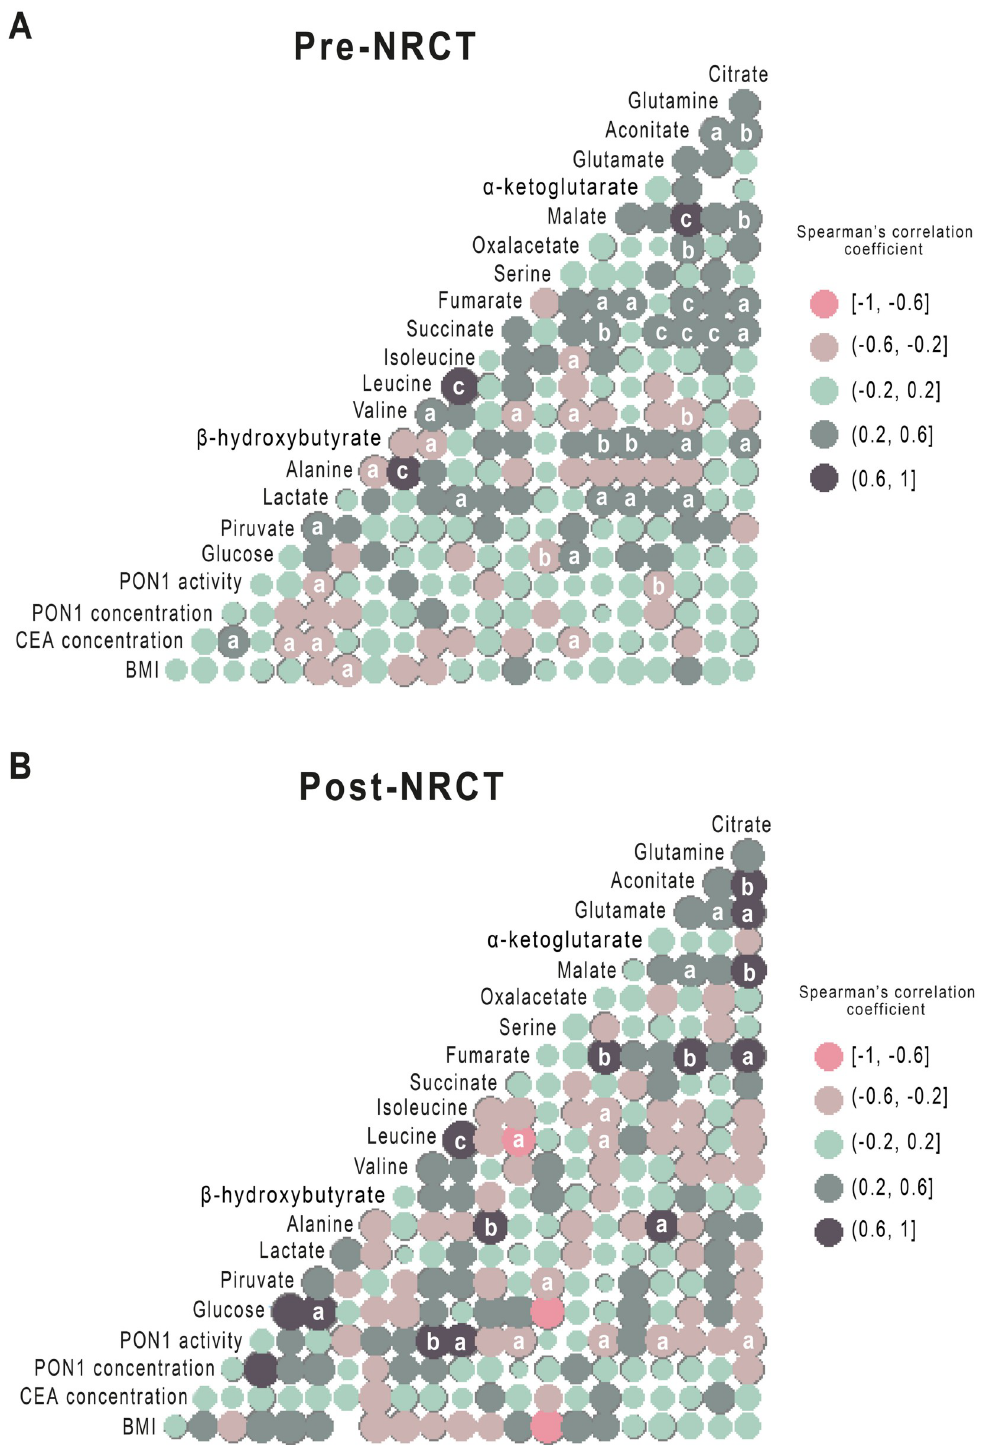
Fig 4. Spearman pairwise correlation matrices of metabolites and Paraoxonase-1 (PON1) activity and concentration pre- and post- Neoadjuvant Radiochemotherapy (NRCT). The magnitude and direction of the correlation of metabolites concentration pre- (A) and post- (B) treatment are shown by the circle size (larger is stronger) and colours (positive correlation in dark blue and negative correlation in pink), respectively. a = p < 0.05; b = p < 0.01; c = p < 0.001.